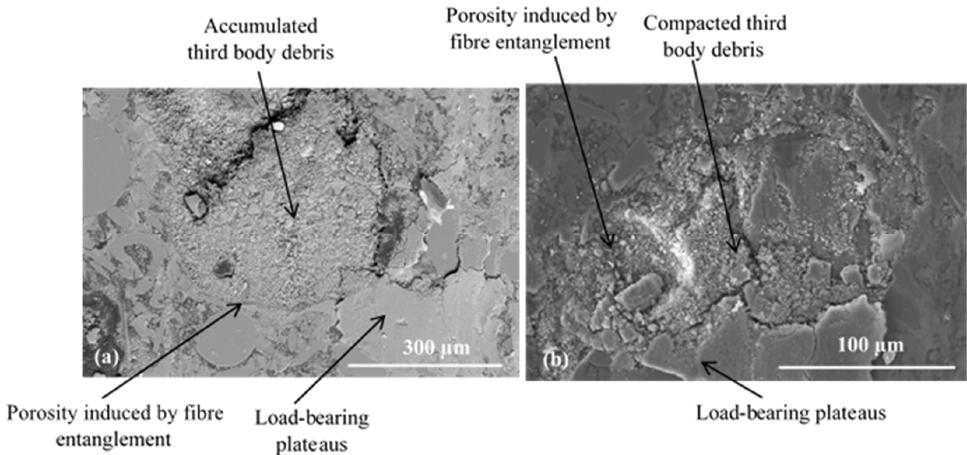
Figure 10. Load-bearing zone at AR for FMFS (SEM, ( a ) BSE and ( b ) SE). Powdered layer